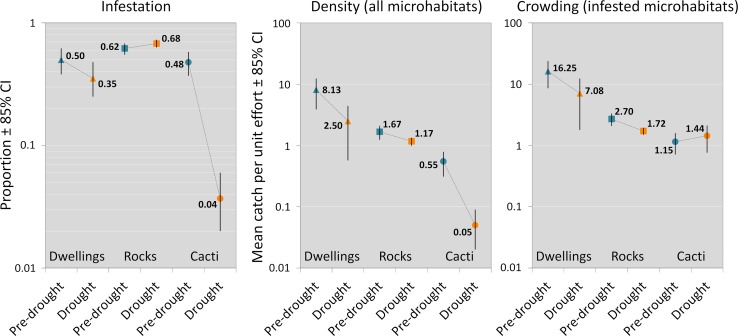
Observed microhabitat infestation by Triatoma brasiliensis, bug density, and bug crowding.Summary metrics by microhabitat (dwellings = triangles; rocks = squares; cacti = circles) both before (‘pre-drought’, blue) and during the drought (‘drought’, orange), with 85% confidence intervals (CI). Note that y-axes are on log10 scale.